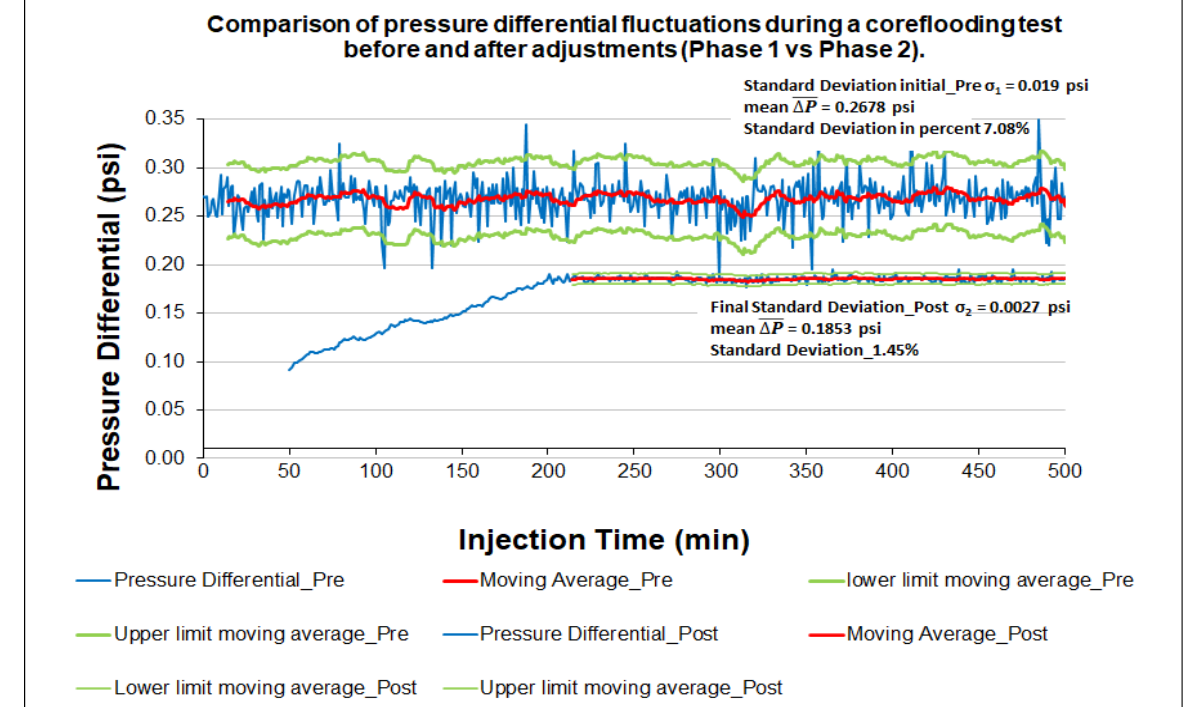
Figure 12: Comparison of pressure differentials data during coreflooding, before and after making the modifications in the permeameter